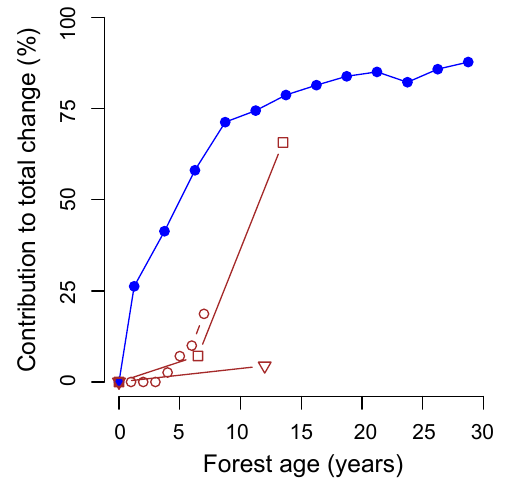
Fig. 5. Change in canopy interception (blue filled circles) and recov- ery of soil permeability (red open symbols) during secondary forest succession. The plot shows the contribution to total change, which is calculated using data from pastures and old-growth forests as end members. The change in canopy interception is calculated based on predictions of relative throughfall using a simple linear regression model and BA ratio data from the 95SFD plots (forest inventories of the years 2009–2011). The change in soil permeability is calculated based on data from secondary forests located in (1) the ASP area (red open squares; from Table 2a in Hassler et al., 2011), (2) south- western Amazonia (red open circles, from Fig. 1 in Zimmermann et al., 2010), and (3) eastern Amazonia (red open triangles; from de Moraes et al.,